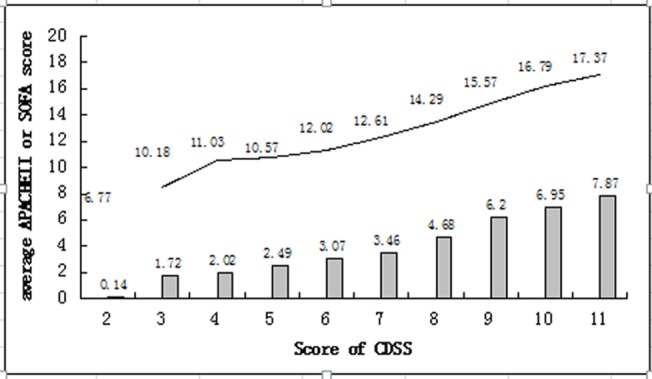
Relativity between CDSS scores and average APACHE II or SOFA scores.CDSS, Chinese DIC scoring system; APACHE, Acute Physiology and Chronic Health Evaluation; SOFA, Sequential Organ Failure Assessment. Bar graph shows average SOFA score. Line graph shows average APACHE II score.